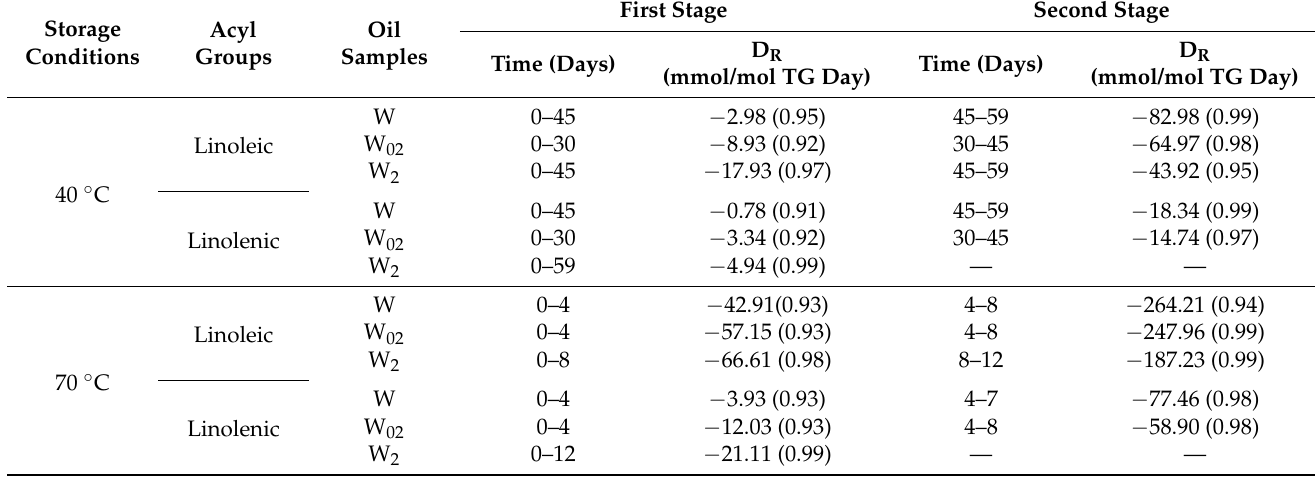
linear path with two slopes in most cases, the first being smaller than the second. The slope of these lines in each stage represents the degradation rate of the corresponding acyl group. These are given in Table 1. Table 1. Degradation rates (D R ) of the most unsaturated acyl groups (linoleic and linolenic acyl groups) expressed in mmol mol −1 TG day −1 , in the different samples submitted to storage at both temperatures, in each one of their stages. The degradation rates agree with the slopes of the linear equations that relate the concentration of these acyl groups and the storage time. The correlation coefficients of these lines are given in brackets.